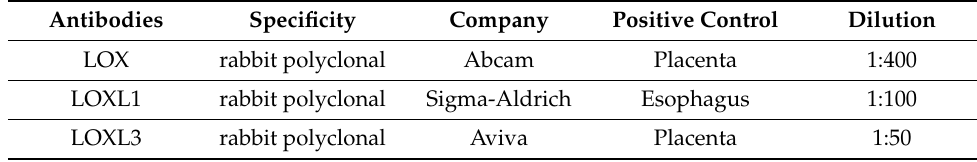
Table 2. Primary antibodies used for